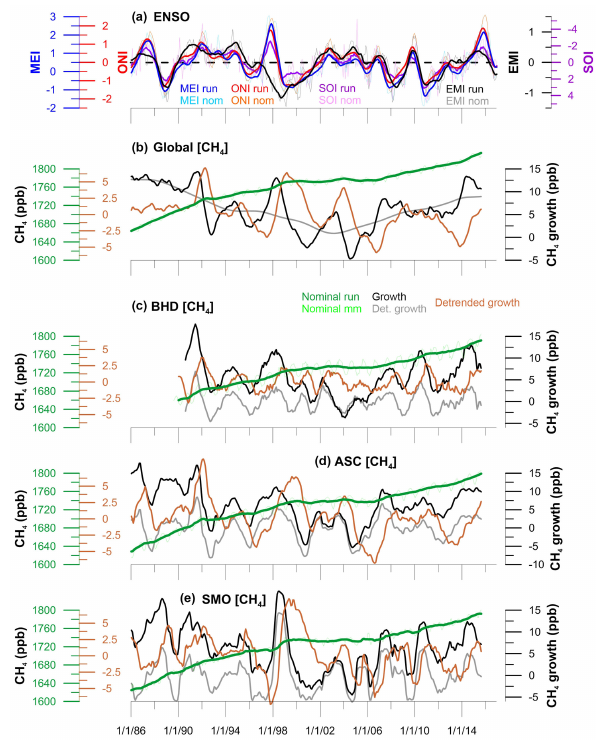
Figure 2. Selected time series of ENSO indices and [CH 4 ]. Panels from top to bottom: (a) Multivariate ENSO Index (MEI), Southern Oscillation Index (SOI), Ocean Niño Index (ONI), and El Modoki Index (EMI) shown for nominal literature data and their 12-month running means. (b) Global [CH 4 ] records; monthly means, 12- month running mean, detrended 12-month running mean, as well as nominal and detrended growth rates. (c) [CH 4 ] records from BHD (d) [CH 4 ] records from ASC. (e) [CH 4 ] records from SMO. BHD, ASC, and SMO display the same records as for global time